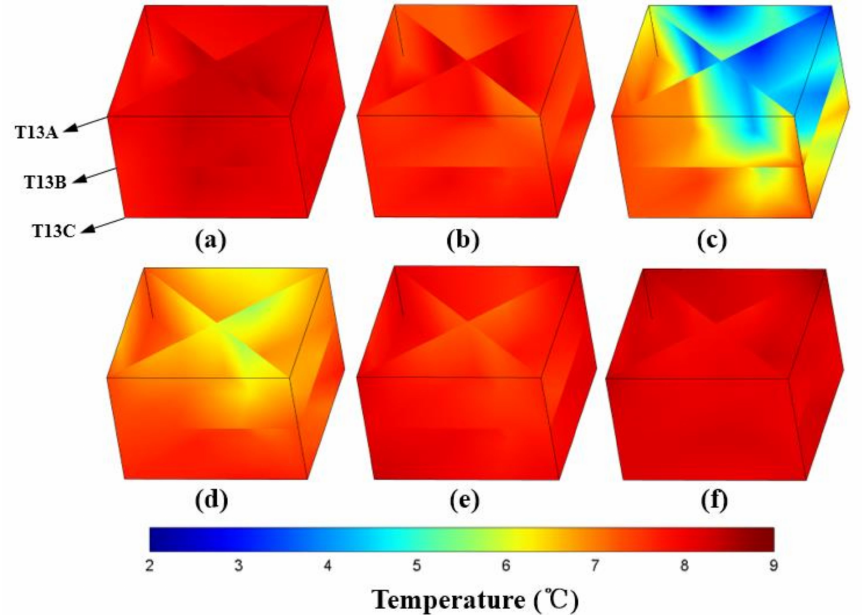
Figure 12. Space distributions of temperatures in the hydrate-bearing sediment from the starting point to the end point of hydrate dissociation. ( a ) 0 min, ( b ) 20 min, ( c ) 28 min, ( d ) 75 min, ( e ) 185 min, ( f ) 345